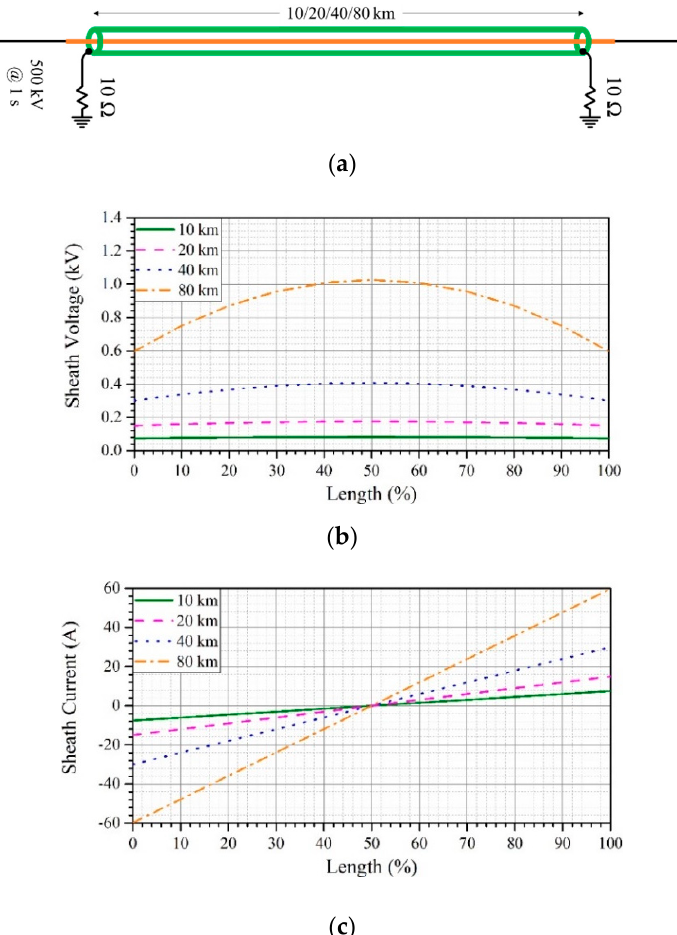
Figure 8. ( a ) A step voltage of 500 kV is applied on the sending end, while the receiving end is grounded via a 250-ohm ground electrode, to emulate a 500 kV / 1 GW HVDC transmission line. The